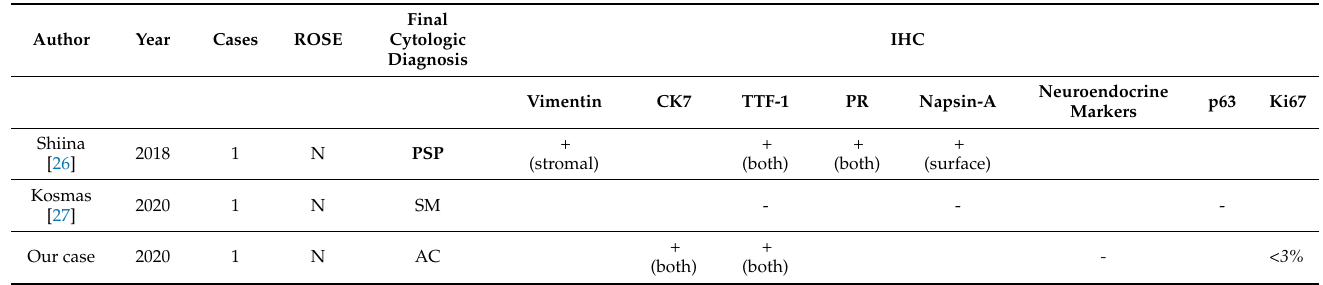
Table 3. Summary of the PSP cytological findings in EBUS-TBNA described in Literature in the last 10 years.